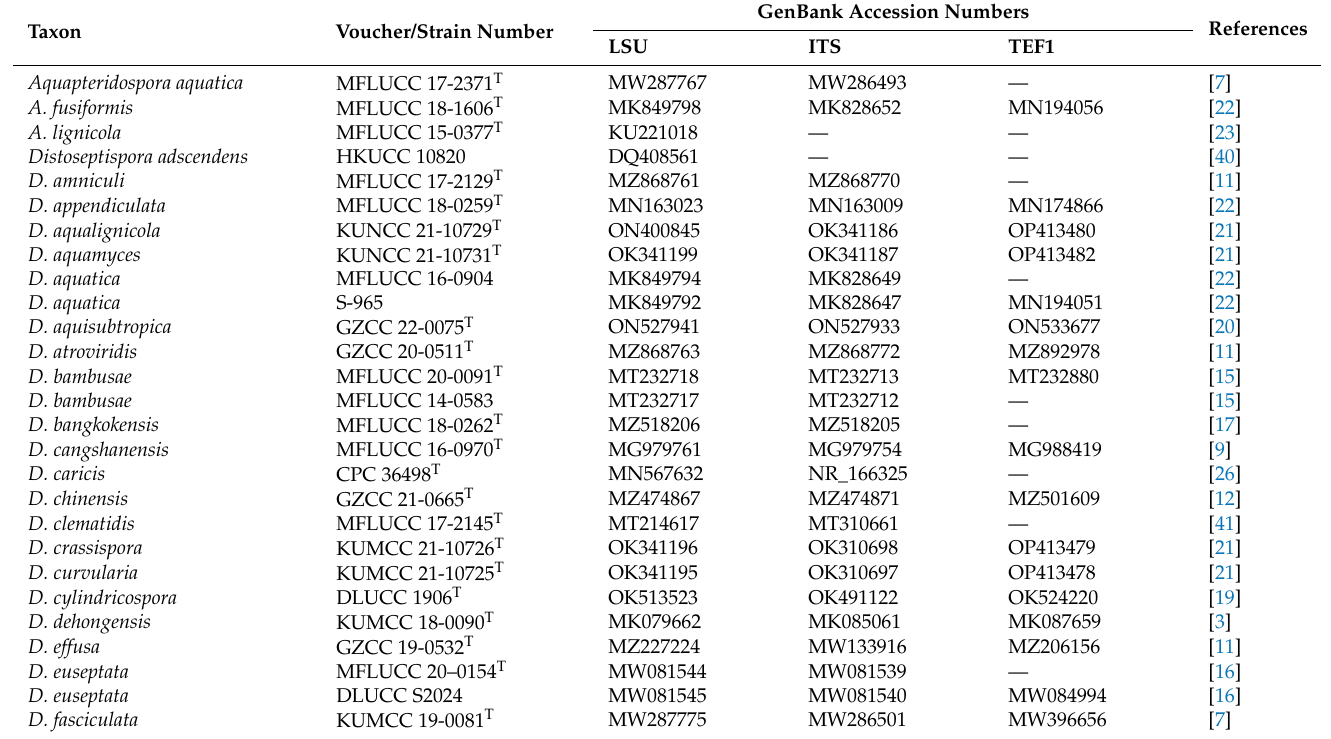
Table 1. List of Distoseptispora species and GenBank accessions used in the phylogenetic analyses. New sequences are in